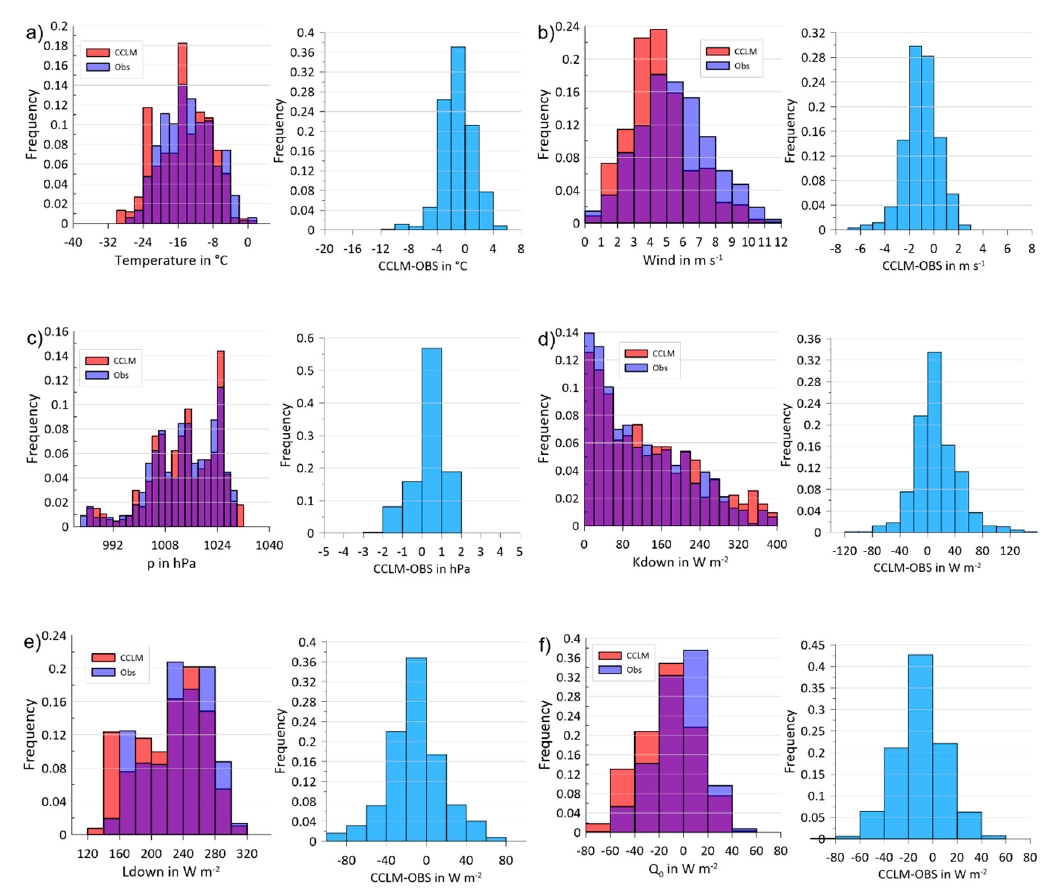
Figure 6. Frequency distributions of measured and simulated values (1 h values) and their differences: ( a ) 2 m temperature, ( b ) 10 m wind speed, ( c ) pressure, ( d ) downward shortwave radiation, ( e ) downward longwave radiation, ( f ) net radiation.